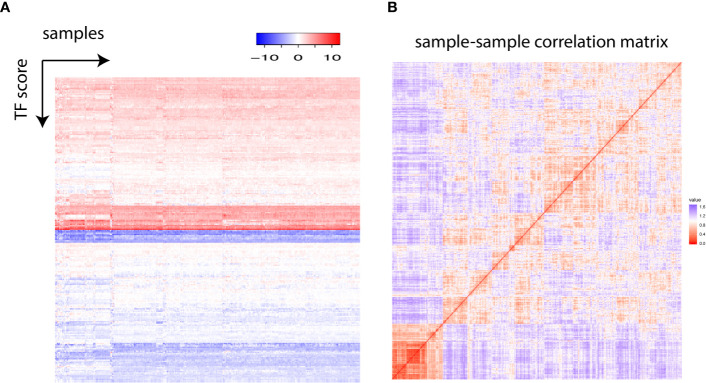

(A) Each row represents one transcription factor, and each column stands for one individual. The transcription factor score is plotted. (B) The sample–sample correlation matrix is visualized as a heatmap.